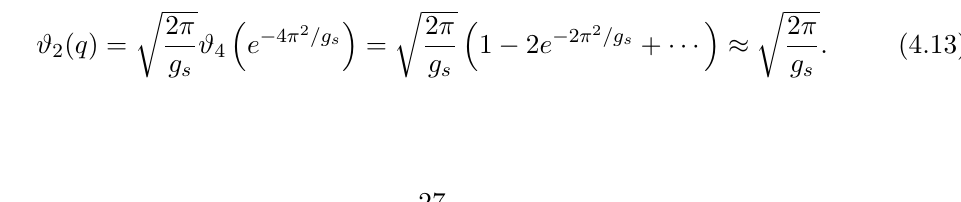
( t ), b (1) ( t ), (cid:22) (1) ( t ). Gray 58 58 59